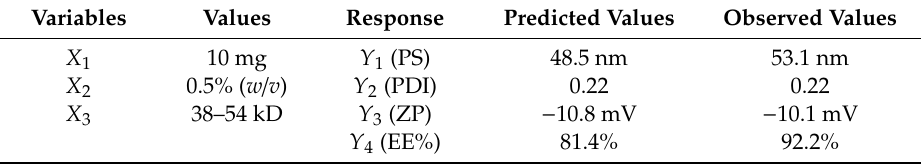
Figure 5. Optimization of PTX-PLGA-NPs showing response surface plots for the effect of using 10 mg PLGA-K38 and 0.5% Kol on ( A ) the desirability value, ( B ) PS (nm), ( C ) PDI, ( D ) ZP (mV) and ( E ) EE%. Table 4. Optimized parameters along with predicted and observed values of responses.